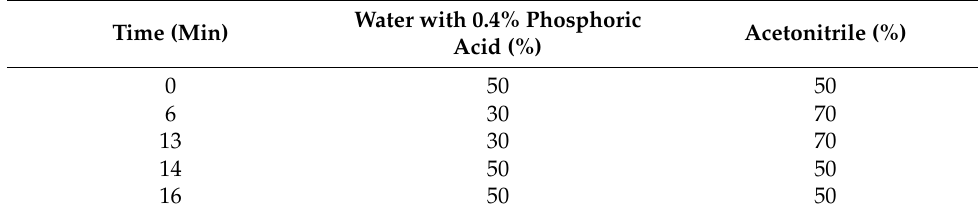
Table 1. Gradient program for separation of the propofol. Time